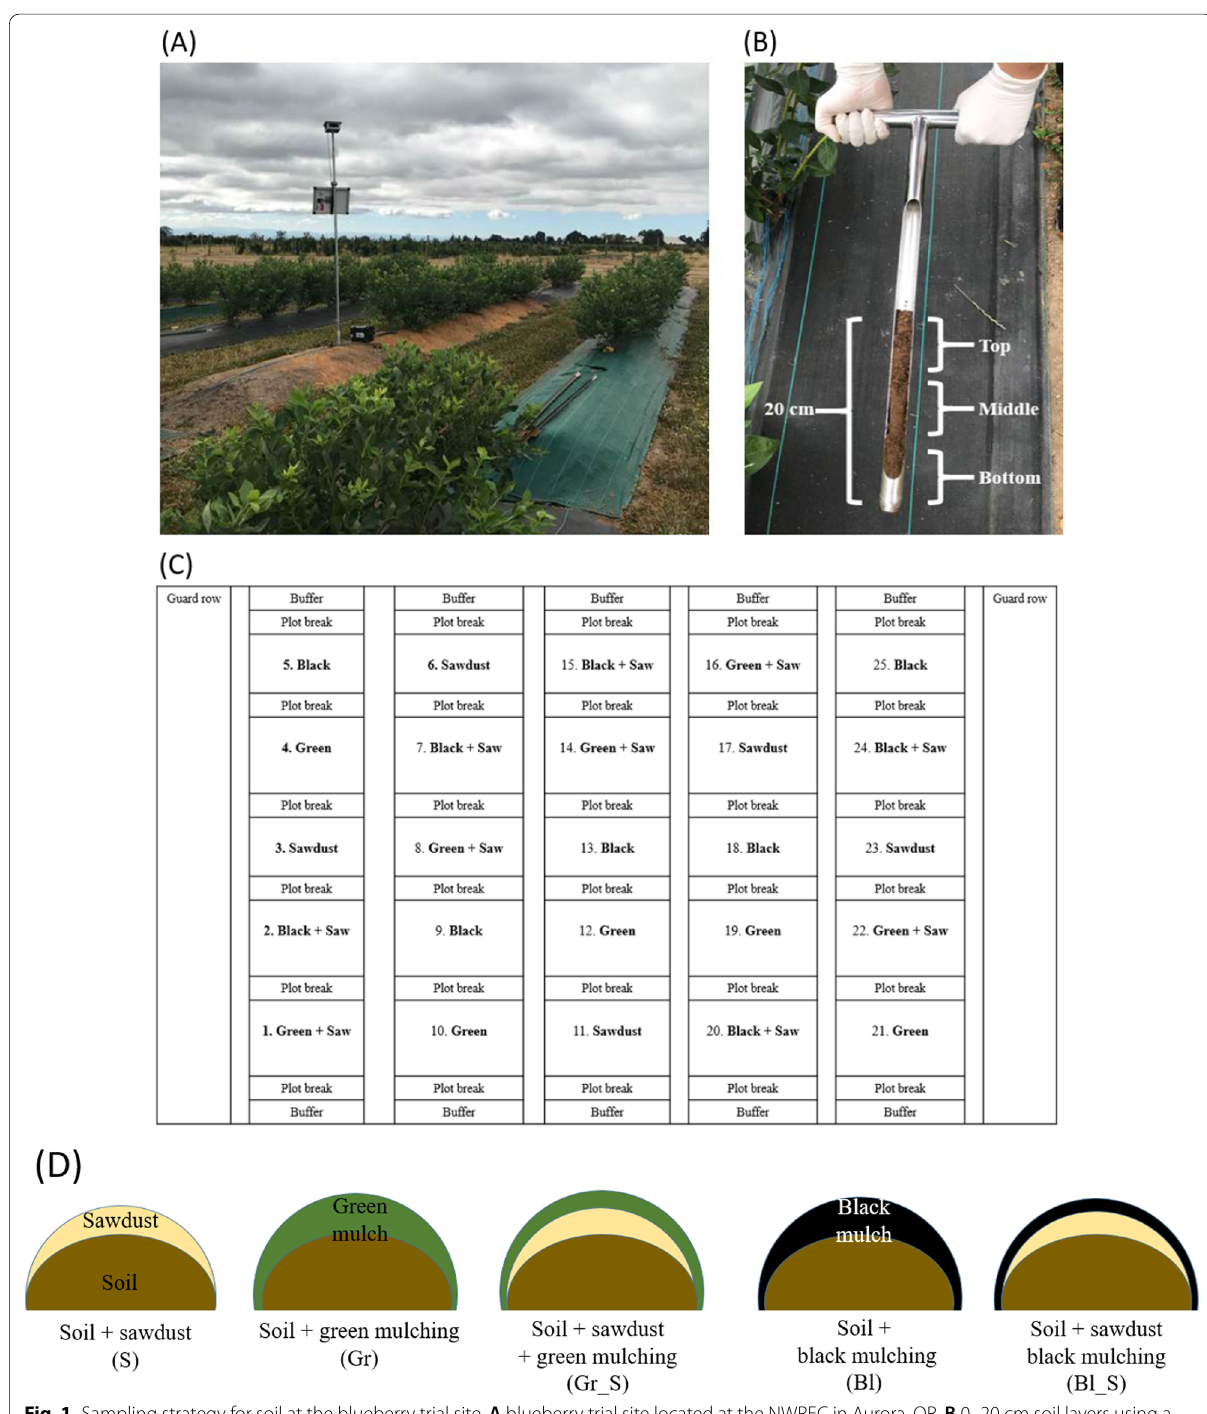
Fig. 1 Sampling strategy for soil at the blueberry trial site. A blueberry trial site located at the NWREC in Aurora, OR, B 0–20 cm soil layers using a soil sampler probe which divide three different even depth, C random split-plot design for five different mulch treatments, and D mulch treatment design. S sawdust, Gr green weed mat, Gr-S sawdust topped with green weed mat, Bl black weed mat, and Bl-S sawdust topped with black weed